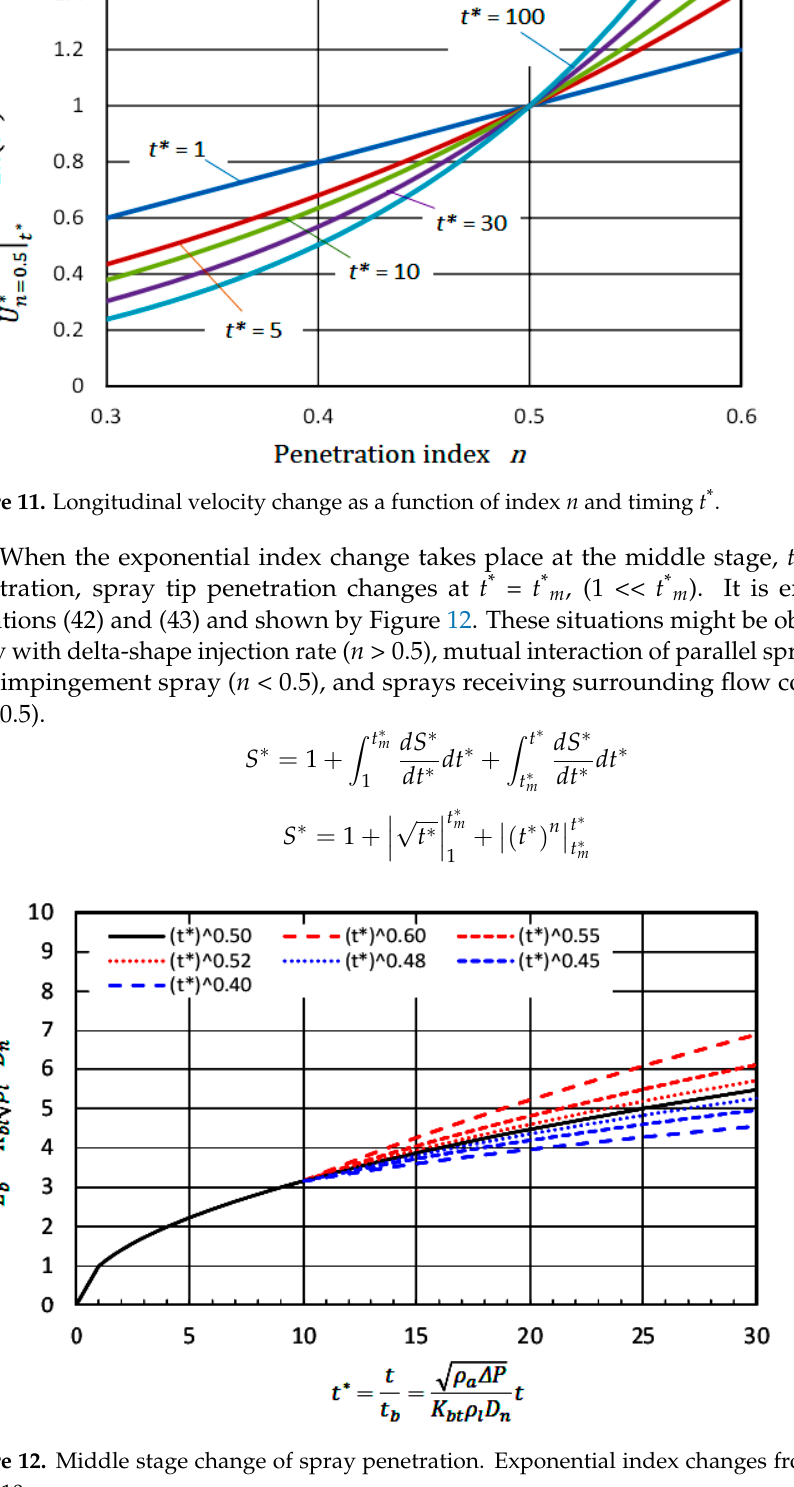
Figure 12. Middle stage change of spray penetration. Exponential index changes from 0.5 to n at t * m = 10. t * m =